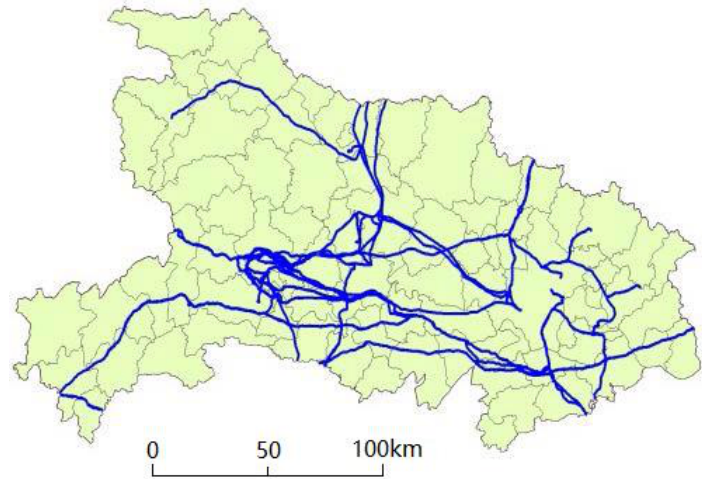
Figure 4. Map of Hubei Province and the distribution of ultra- and extra-high-voltage power line corridors shown in blue.